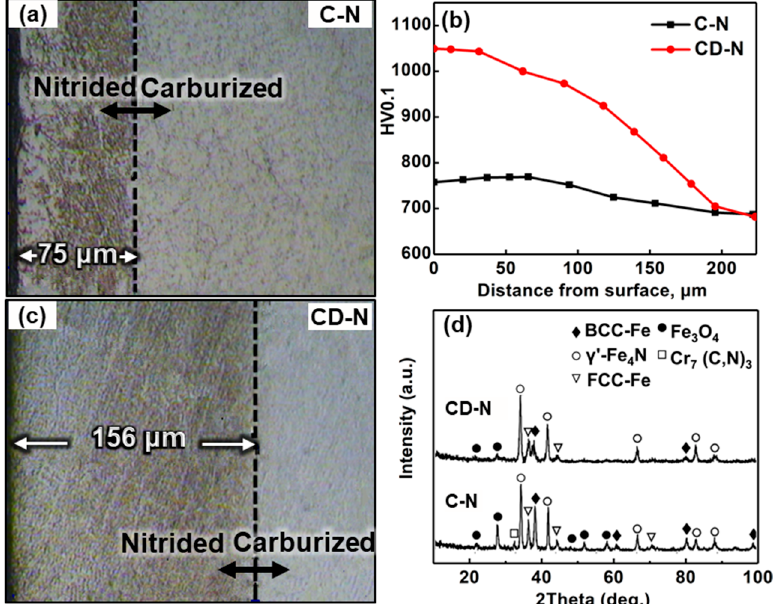
Figure 3. ( a ) Optical micrograph of cross-sectional microstructure of the nitrided layer of M50NiL Sample C-N nitrided at 520 °C for 4 h; ( b ) Microhardness profiles along the modified layers of Sample C-N and Sample CD-N nitride at 520 °C for 4 h; ( c ) Optical micrograph of cross-sectional microstructure of the nitrided layer of M50NiL Sample CD-N nitrided at 520 °C for 4 h; ( d ) XRD patterns of Sample C-N and CD-N nitride at 520 °C for 4 h.